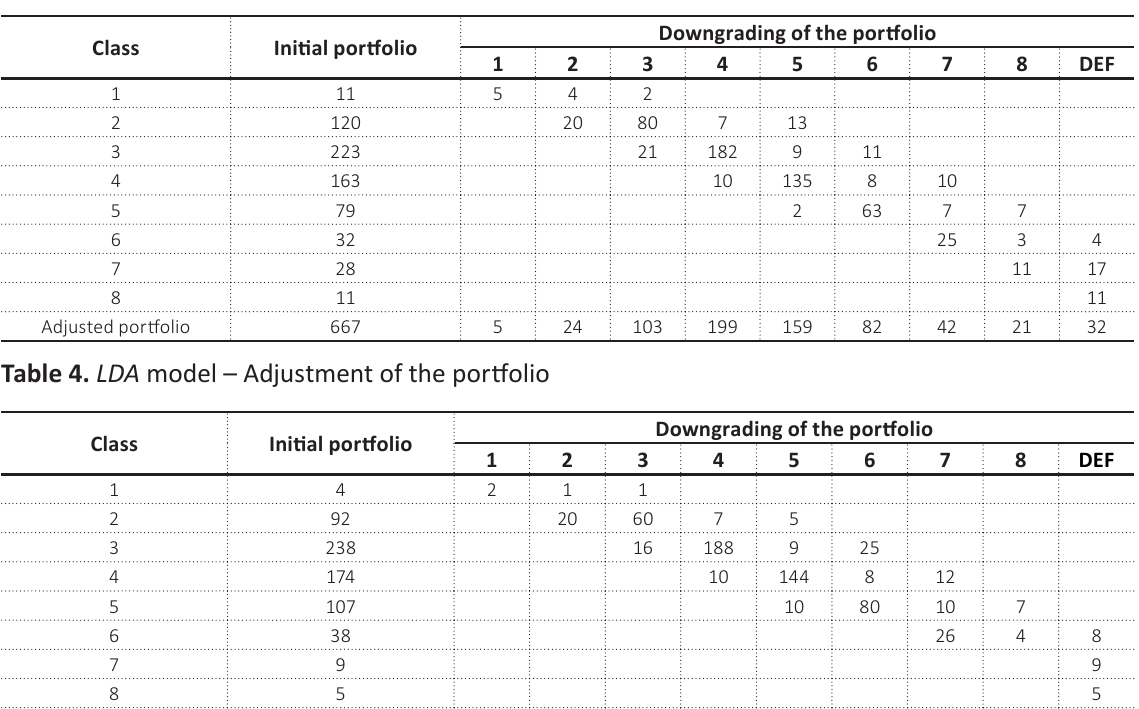
Table 3. LR Model – Adjustment of the portfolio